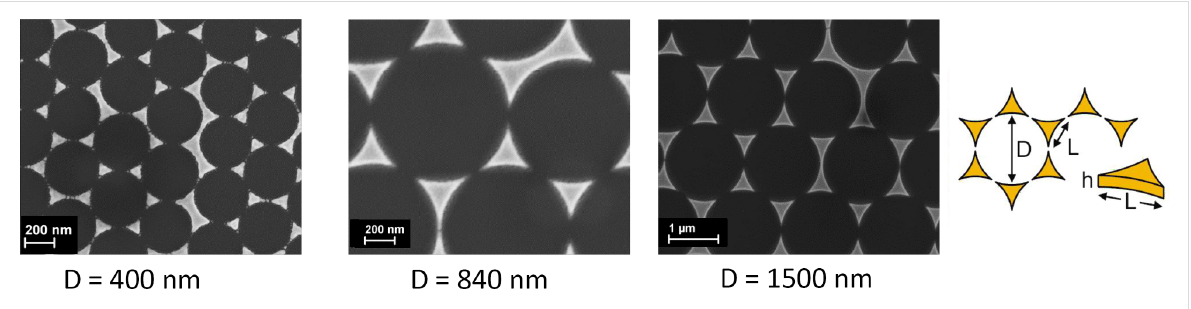
Figure 2: SEM images of gold triangle arrays on silicon substrates which are fabricated using polystyrene spheres of different diameters. The sketch on the right shows the used denominations to characterise the triangle array.